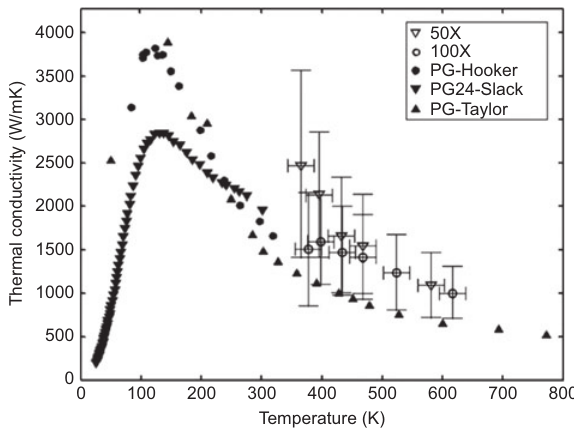
Figure 3 Thermal conductivity of the suspended CVD graphene measured using the 100 × and 50 × objective lens as a function of the measured graphene temperature. Also shown in comparison are the literature thermal conductivity data of pyrolytic graphite samples as a function of temperature. (Reproduced from Ref. [42] with permis- sion from the American Chemical Society.)